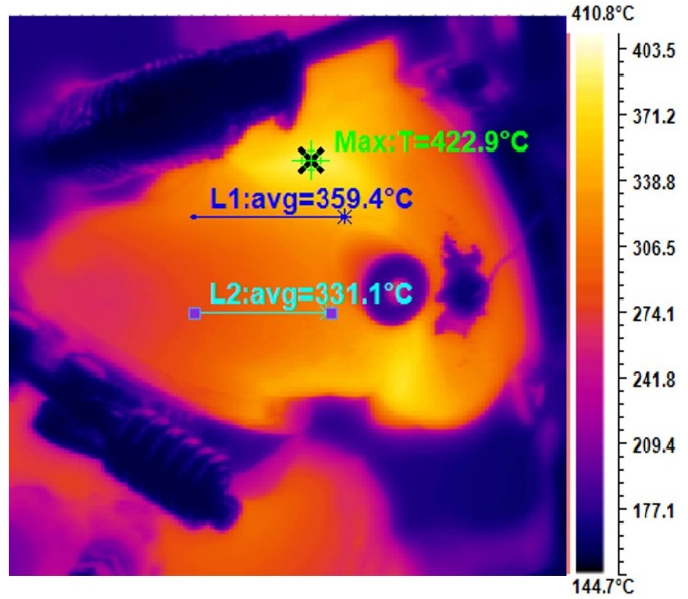
Figure 10. IR-image of the turbine housing.